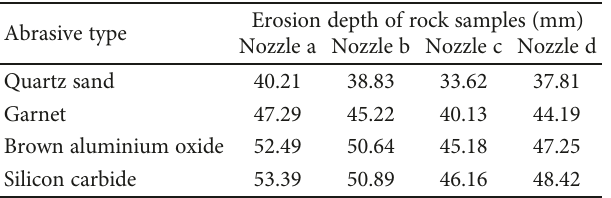
Table 11: Erosion depth of the di ff erent nozzles when abrasive is di ff erent.